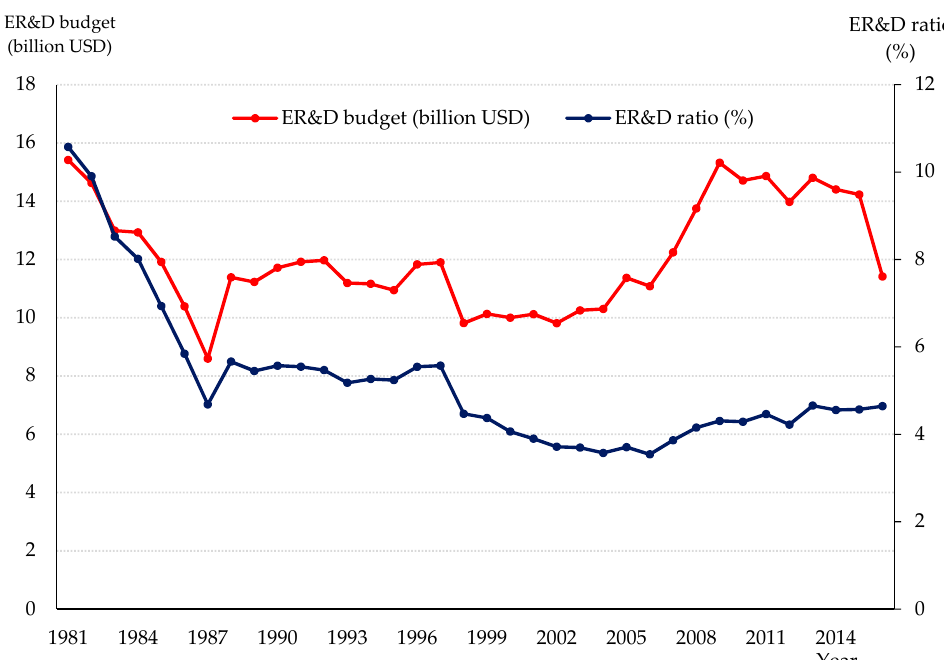
Figure 1. ER&D budget and the ratio of ER&D investment to total R&D investment in OECD countries [35].